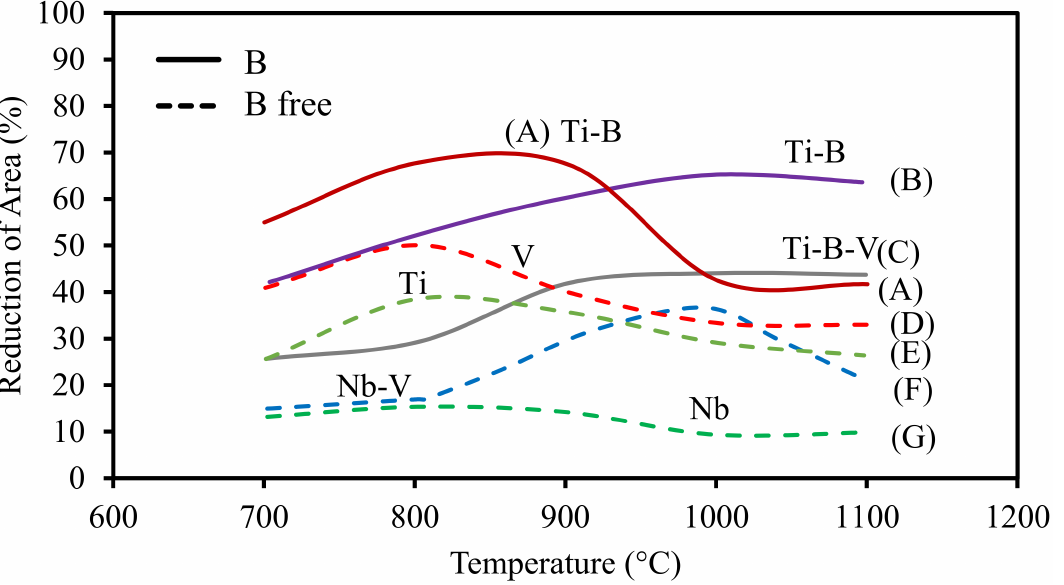
Figure 30. Hot ductility curves for high Al TWIP steels having a variety of microalloying elements, Nb, Nb-V, Ti, V, Ti-B and Ti-B-V. Steels had the base composition 0.6% C, 18% Mn, 1.5% Al and the cooling rate and strain rate were 60 K/min and 3 × 10 − 3 s − 1 , respectively [22,26,27,65,66]. Table 3. Composition of steels in Figure 30, with their % wt.per.cent and %RA at 900 ◦